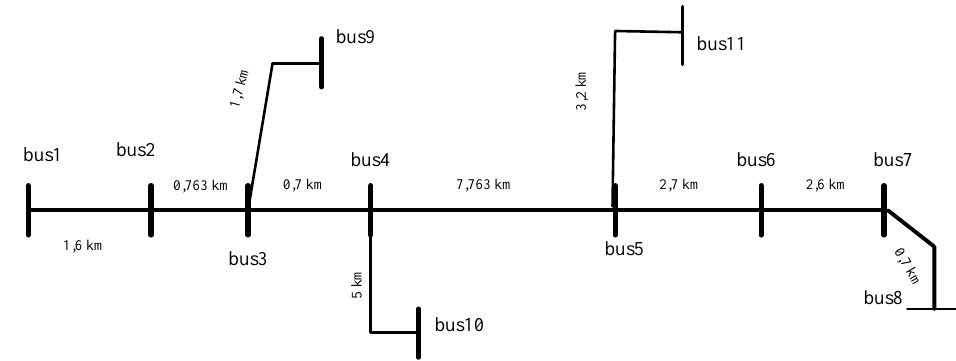
Figure 10. Single-line diagram of the sample feeder with 11 nodes.